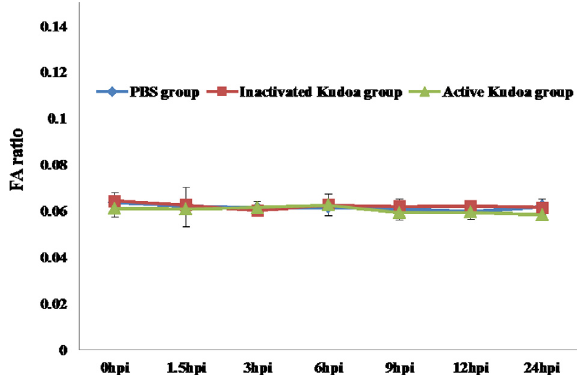
Figure 2. Kinetics of the fluid accumulation (FA) ratio in ddY suckling mice in phosphate-buffered saline, 5 · 10 6 inactivated spores/mouse and 5 · 10 6 active spores/mouse groups. Means of FA ratios ± standard deviation for five mice are shown. No significant differences ( P < 0.05) were found at any time interval. Hpi: hours